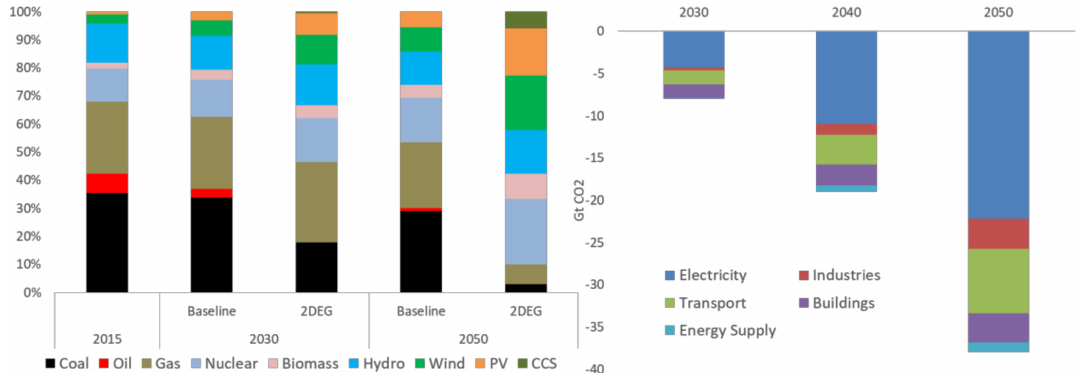
Figure 2. Global energy system restructuring in 2DEG: ( i ) Global power generation mix (in %), ( ii ) Emission reduction from Baseline by sector (Gt